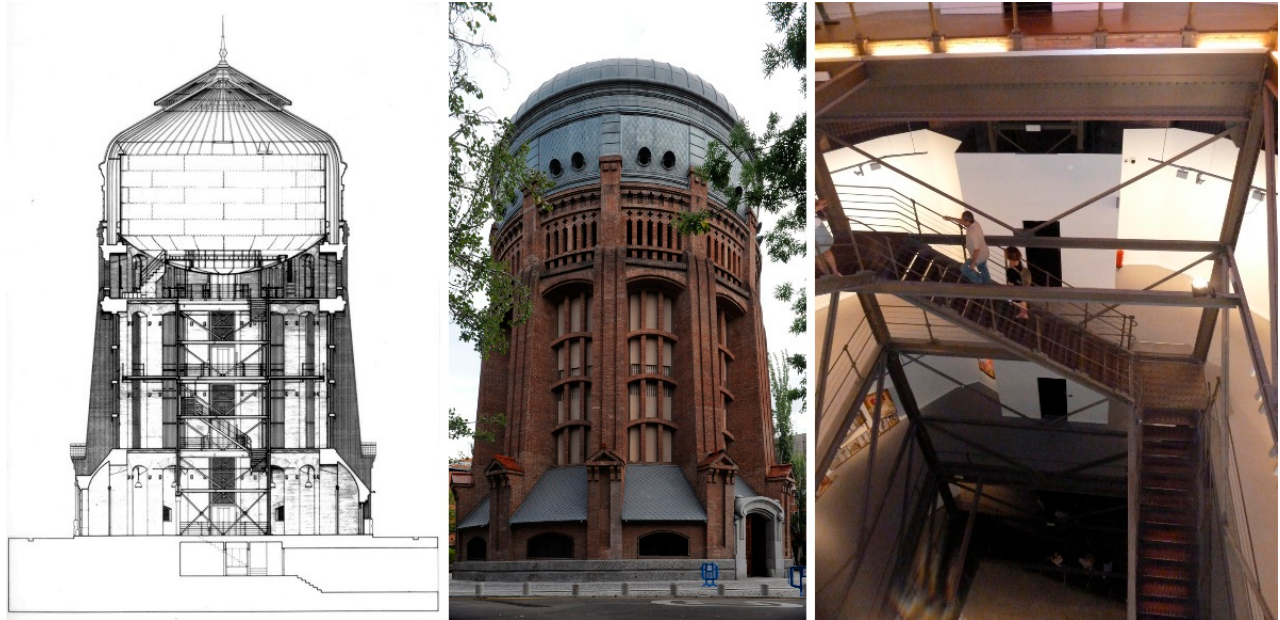
Figure 10. First water tank (1907) converted into exhibition hall (1985). Source: FMA.